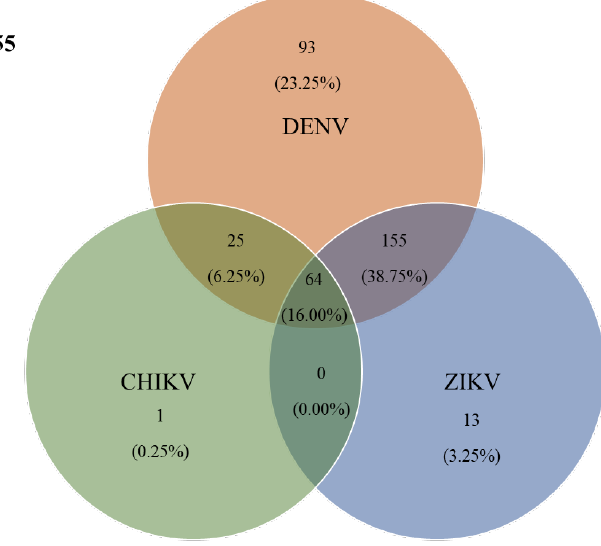
Figure 4. Co-circulation of three ELISA-positive arboviruses in Bangphae district, Ratchaburi province, Thailand. Number and percentage (%) of samples found to be positive by ELISA for immunoglobulin G (IgG) antibodies to single or multiple exposures of DENV, ZIKV, and CHIKV. Table 4. Co-circulation of three arboviruses according to ELISA [ n